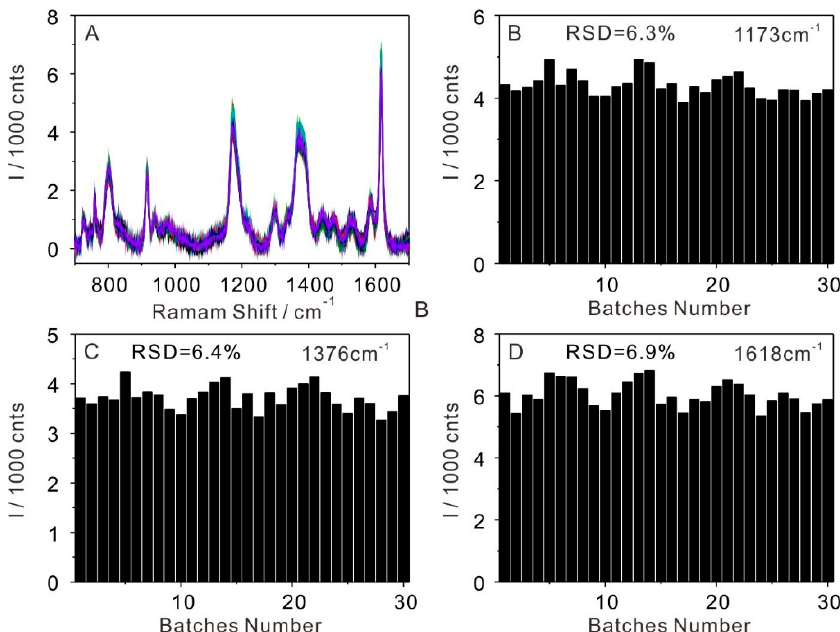
Figure 1. ( A ) SEM observations on Au nanoparticle (NP) arrays (inset in A: TEM of self-assembled Au NP arrays); ( B ) nanoparticle size distribution histograms of Au NPs arrays; ( C ) interparticle gap distribution histograms of Au NPs arrays; ( D ) absorbance spectra of self-assembled Au NPs arrays transferred onto a quartz glass surface.